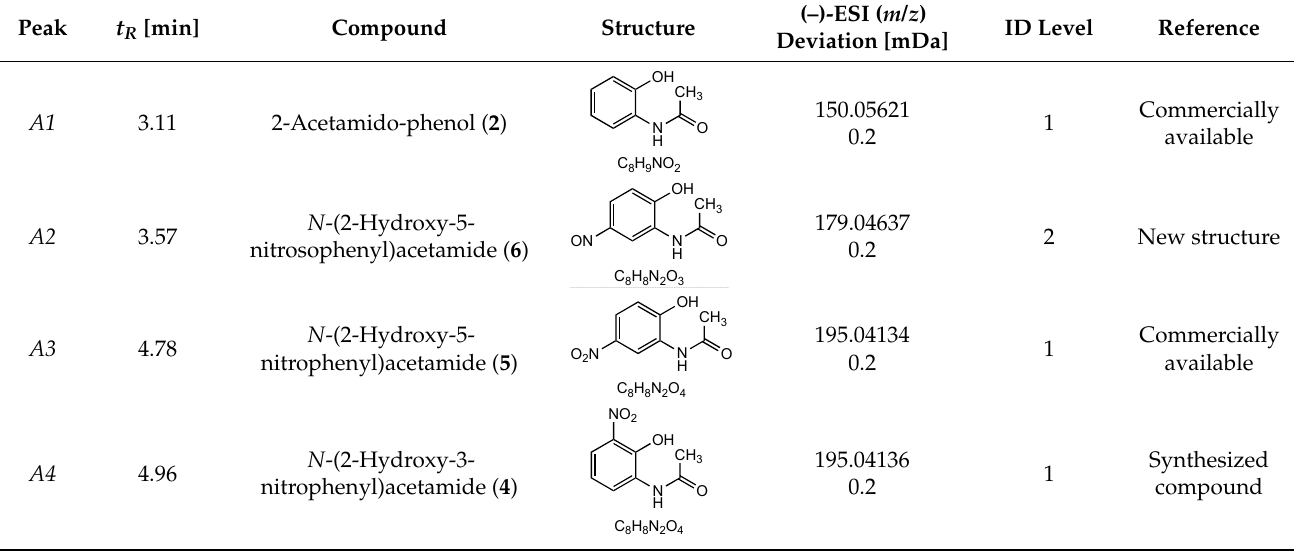
Table 1. Summary of compounds identified in total bacterial culture extracts obtained from A. aminovorans and P. polymyxa after incubation with 2 . The (–)-ESI mass spectra are shown in Figure S2. The identification levels are based on the guidelines of Metabolomics Standards Initiative [18–21].